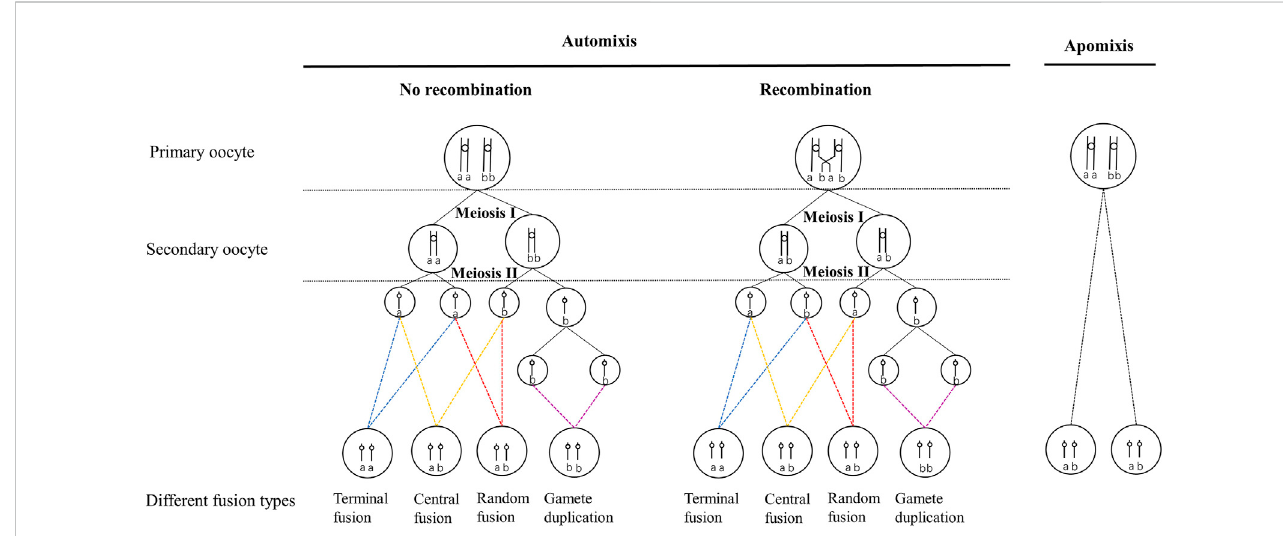
FIGURE 1 Different cytological mechanisms of automictic thelytoky during meiosis and their genetic effects on progeny at a locus in the event of and without recombination. The circle represents the nuclei. Vertical lines indicate chromatids, small circles connecting vertical lines indicate centromeres, and the lowercaselettersindicatealleles atspeci fi cloci.Thefourdifferentcolored dashedlinespointtofourdifferentcell fusionprocesses ofautomixis.Theparentis heterozygous, indicated by ab. Homozygous progeny was indicated by aa or